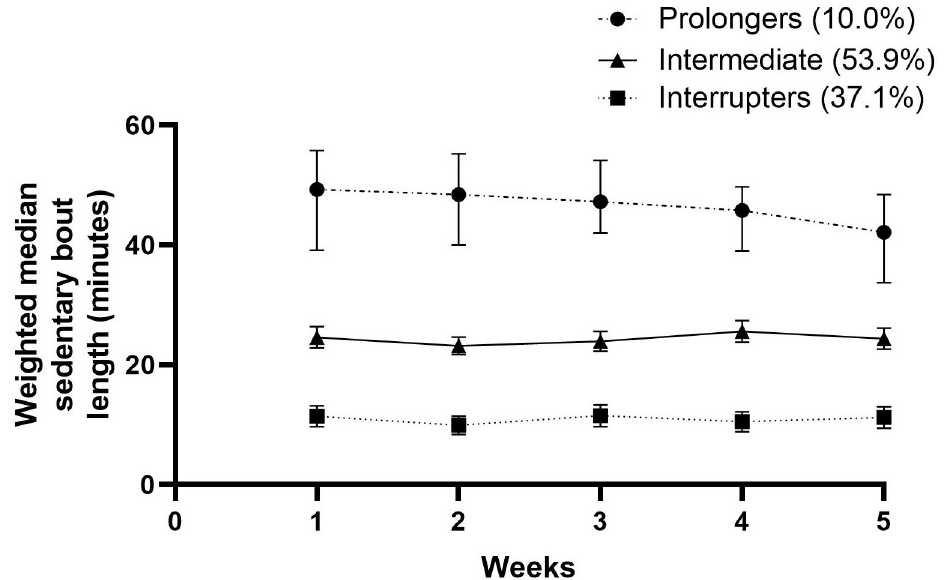
Fig 5. Weighted median sedentary bout in minutes per day between three weeks and eight weeks after discharge from the hospital in stroke